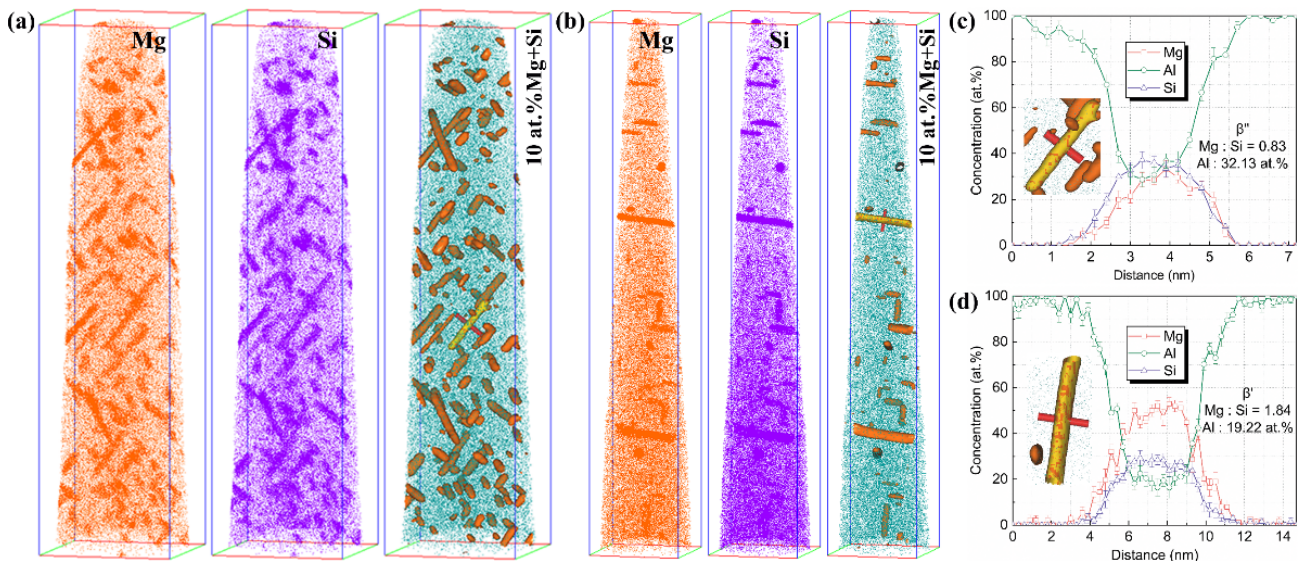
Figure 5. The 3D atom maps of Mg, Si, and a 10.0 at% Mg + Si iso-concentration surface of ( a ) NA10 min-AA (86 nm × 90 nm × 260 nm) and ( b ) NA1440 min-AA (82 nm × 82 nm × 480 nm); Al(Green), Mg(Orange), and Si(purple). The representative 1D concentration distribution of ( c ) β″ and ( d ) β′ is marked in yellow in Figure 4a,b, respectively.